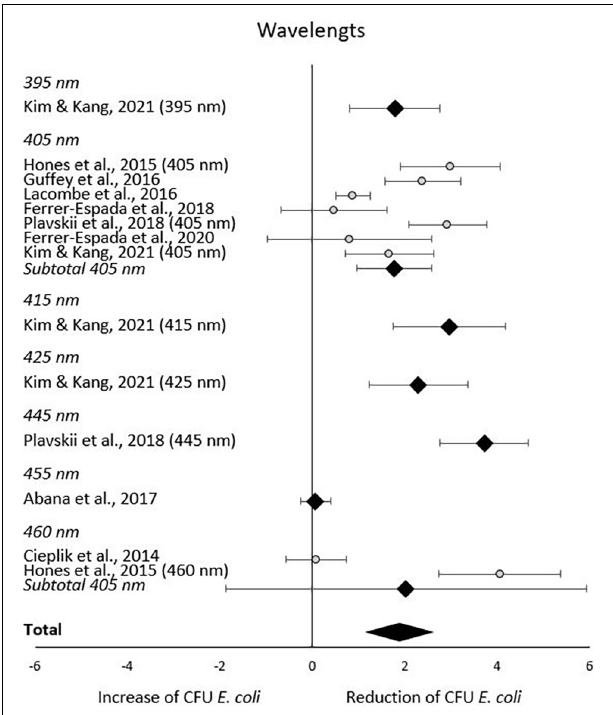
FIGURE 5 | Forest plot of reduction of E. coli post blue light exposure by